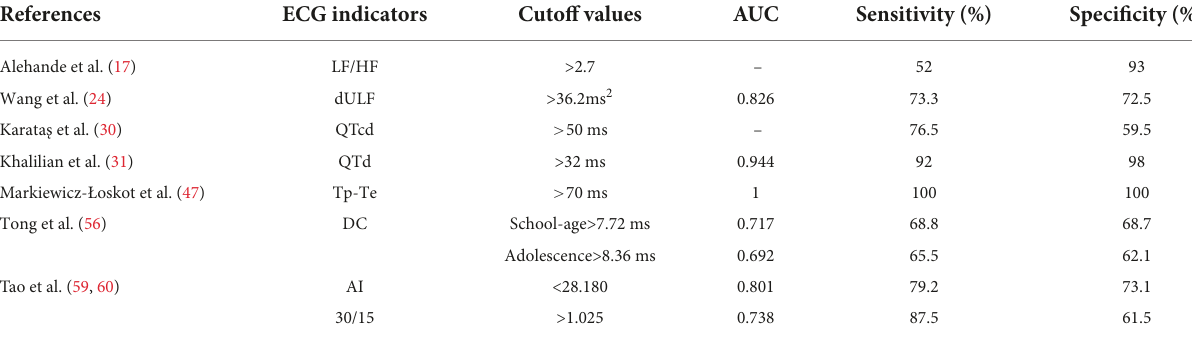
TABLE 1 Predictors of the diagnosis of pediatric VVS.